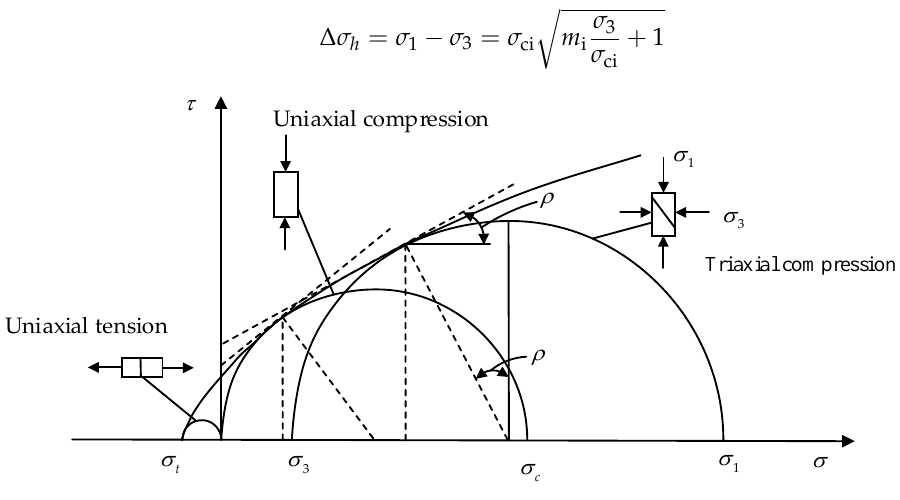
Figure 2. Failure envelope of intact rock.